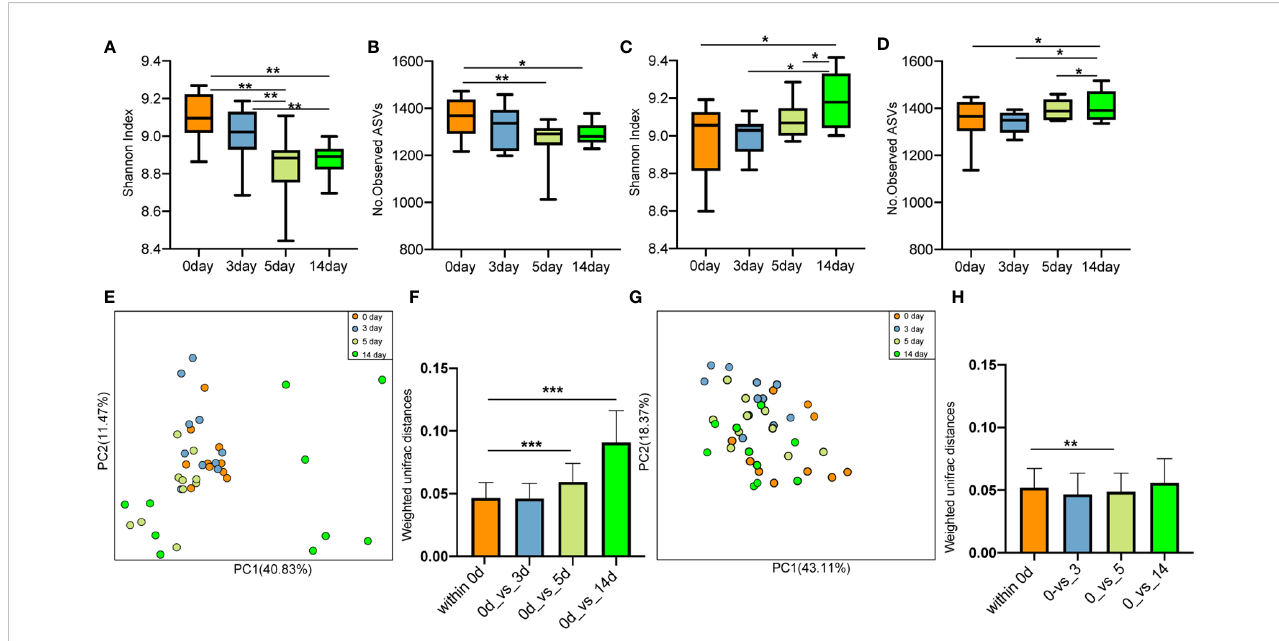
FIGURE 9 Effect of antibiotic and geraniol on gut microbiotas of dairy cows in the treatment of mastitis. Dynamic changes of (A) Shannon index and (B) Number of observed ASVs of gut microbiotas in dairy cows treated with antibiotics; Dynamic changes of (C) Shannon index and (D) Number of observed ASVs of gut microbiotas in dairy cows treated with geraniol; Dynamic cluster of bacteria in milk of dairy cows with mastitis supported by Principal component analysis based on Weighted Unifrac distance before and after using antibiotic (E) and geraniol (G) ; Phylogenetic distance of gut microbiotas in cows after administration of antibiotics (F) geraniol (H) and before administration. utot-hoc Dunn ’ s multiple comparisons test: ∗ < 0.05, ∗∗ < 0.01 and ∗∗∗ < 0.001).